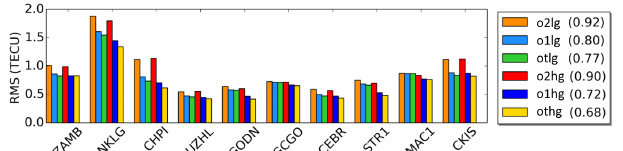
Figure 13. RMS values for the “o2hg”, “o1hg”, “othg”, “o2lg”, “o1lg” and “otlg” products computed at the 10 receiver stations shown in Fig. 10 during September 2017. The values in parentheses in the legend are the average RMS values over all 10 receiver sta- tions for the entire test period between 1 and 30 September 2017.